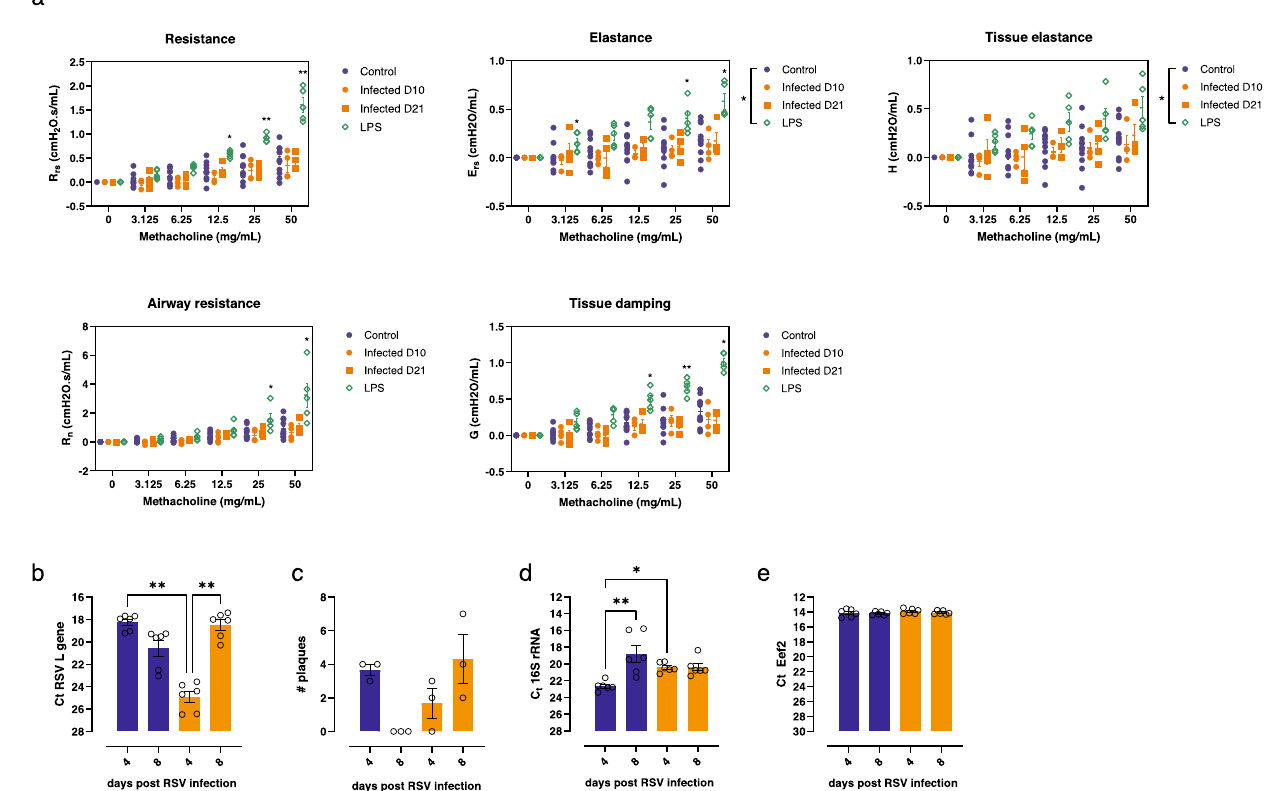
Fig. 9 | Evaluation of lung functioning and susceptibility to opportunistic infectionsof T.b.brucei infectedmice.a Groupsof atleastfour C57BL/6JRjmice were infected via the bite of a T. b. brucei AnTar1 infected G. morsitans tsetse fl y. After sedation using pentobarbital at 10 and 21 dpi, mice were intubated and connected to the FlexiVent TM system. Lung parameters were measured upon inhalation of increasing doses of methacholine. Data are represented as means± standard error of the mean of two independent repeats. Total number of mice: control ( n =11), 10 dpi ( n =4), 21 dpi ( n =4) and LPS ( n =5). Statistical comparisons were made using the Kruskal – Wallis test. * p <0.05, ** p <0.01. b – e Mice were ran- domly allocated to two groups ( n =6) of which one was infected with T. b. brucei AnTat1.1E PpyRE9 via the bites of infected tsetse fl ies. The other group served as non-